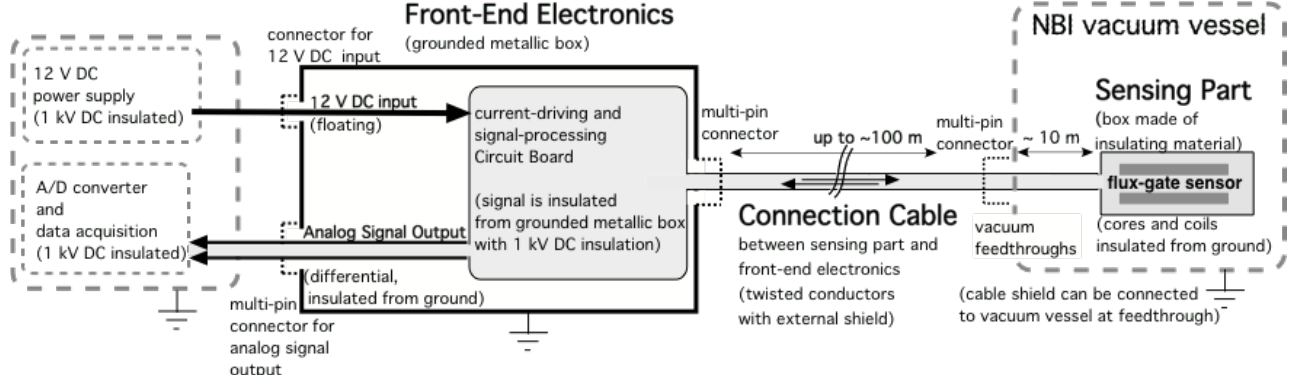
Figure 4. Signal paths and grounding scheme of the “engineered” fluxgate magnetic sensor